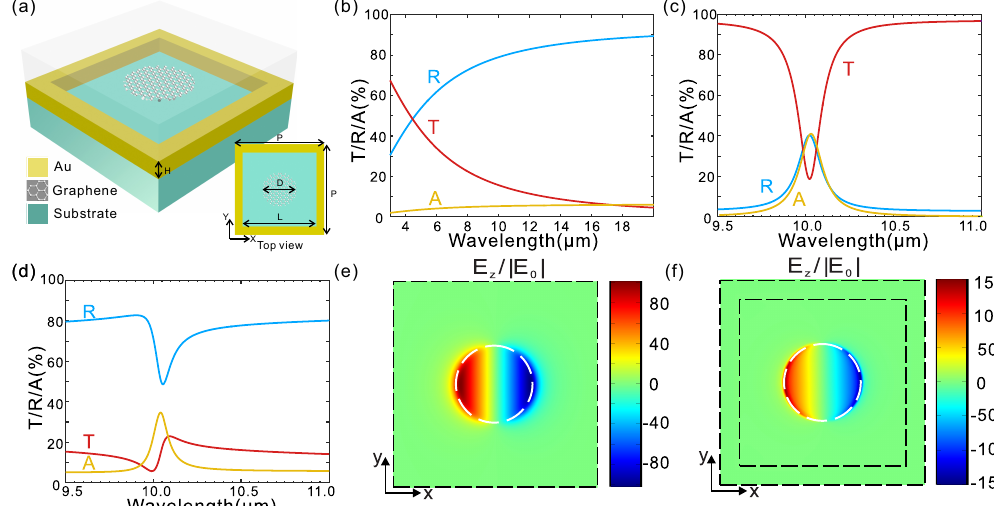
Figure 1. A hybrid metal-graphene Fano-resonant metamaterial. ( a ) Schematic of the hybrid metamaterial. ( b – d ) Simulated spectra of transmission, reflection and absorption for different combination of nanostructured gold film and graphene nanodisks including nanostructured gold film without graphene nanodisks ( b ), graphene nanodisks without the nanostructured gold